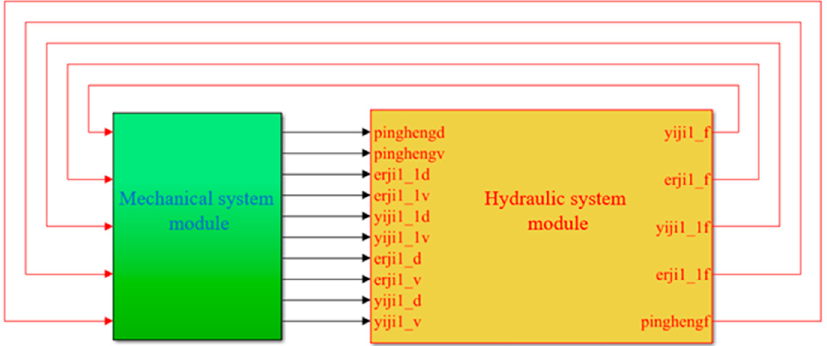
Figure 4. Mechanical-hydraulic co-simulation